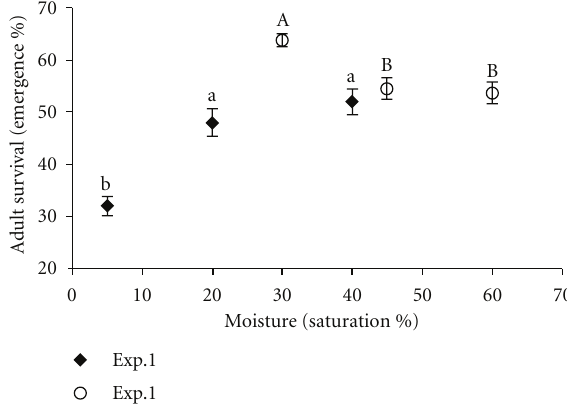
Figure 4: Mean percentage ( ± S.E.) of adults emerging when maintained at 5, 20, and 40% soil saturation in Exp. 1 and at 30, 45, and 60% soil saturation in Exp. 2. Means with di ff erent lower case letters are significantly di ff erent (Exp. 1, n = 24) and means with di ff erent upper case letters are significantly di ff erent (Exp. 2, n =